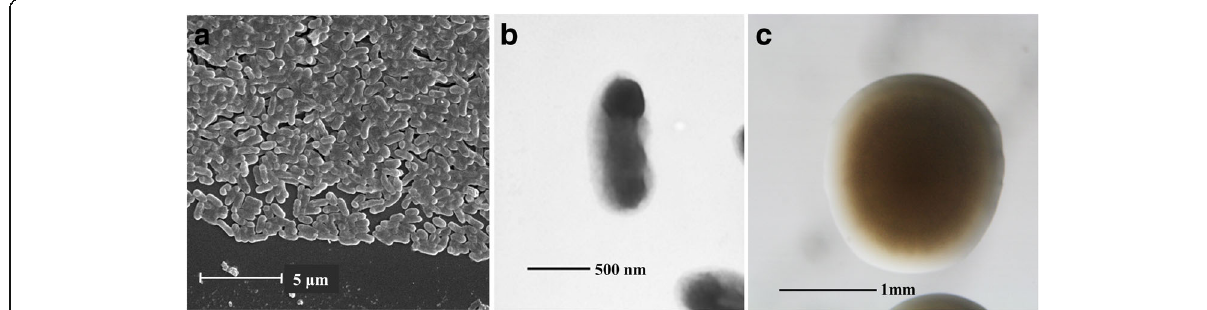
Fig. 1 Images of Ensifer meliloti Mlalz-1 using scanning ( Left ( a )) and transmission ( Center ( b )) electron microscopy as well as light microscopy to visualize colony morphology on solid media ( Right ( c